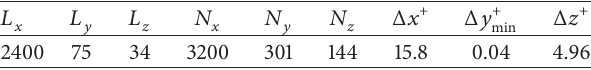
Table 1: Numerical parameters for the simulations presented. 𝐿 and 𝑁 refer to the size (measured in displacement thickness at 𝑥 = 0 ) and the number of modes, respectively.